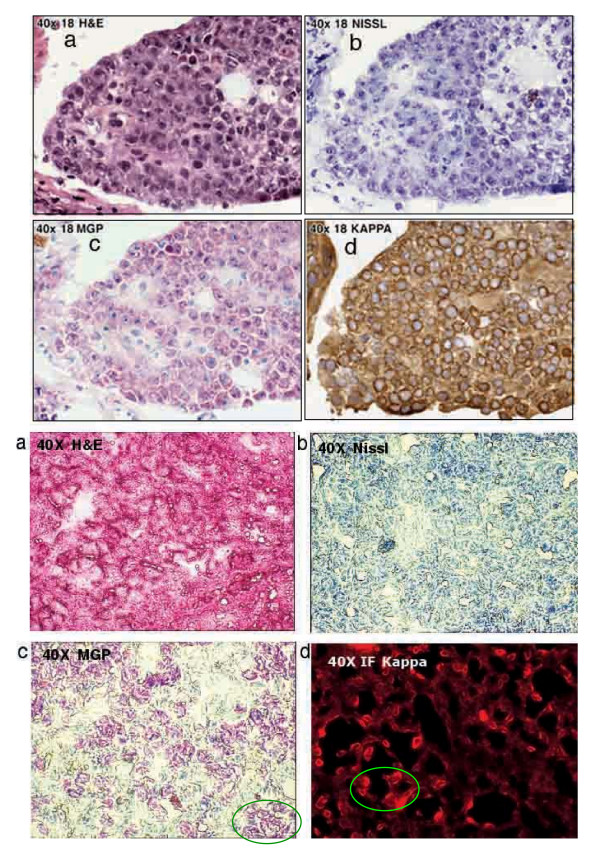
Histochemical staining of frozen sections of an intraperitoneal primary mouse plasma cell tumor. A nodule rich in plasma cells can be seen in the midst of surrounding stromal and fat cells. The stains of the sections are as follows: H&E, hematoxylin and eosin; Nissl; MGP (methyl green pyronin) and kappa (immunoperoxidase in the top four panels or immunofluorescence in the bottom four panels) staining of immunoglobulin kappa light chains). The images in the top four panels represent frozen sections stained and mounted under cover slips in a distant histology laboratory and captured using high quality optics in a photographic studio. Those in the bottom four panels reflect the challenges of interpreting microscopic views on a microscope optimized for LCM, viewing frozen sections that had been processed and stained with the utmost speed to minimize RNA damage and lacking cover slips. Ovals indicate clusters of plasma cells with characteristic MGP staining and rich in Ig κ protein.